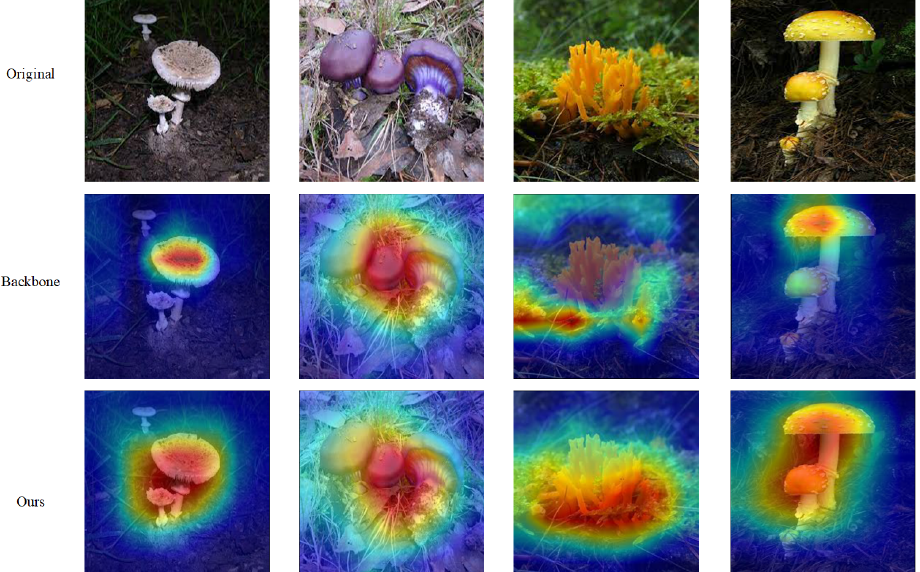
Figure 10. The thermodynamic diagrams of backbone model and